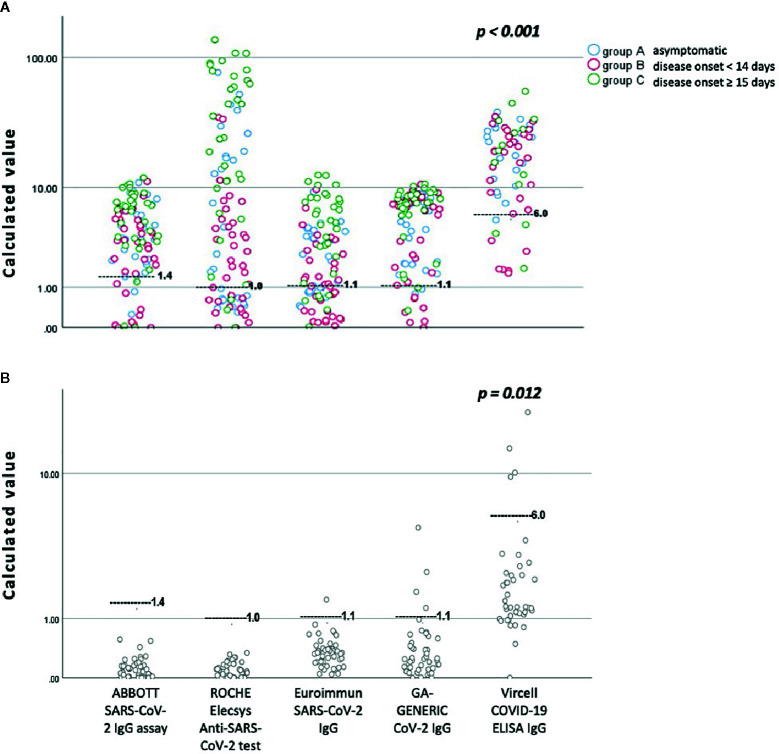
An overview of anti-SARS-CoV-2 IgG antibodies detected by all assays evaluated in this study, according to the day of blood sampling from the day of disease onset. (A) Sera specimens from patients with confirmed COVID-19 disease. (B) Sera specimens from volunteers collected before the SARS-CoV-2 outbreak. The black gray line represents the cutoff for positivity of each immunoassay. For a detailed presentation of the results, the reader is referred to
Tables 2
 and
3
 and the printed version of this manuscript.